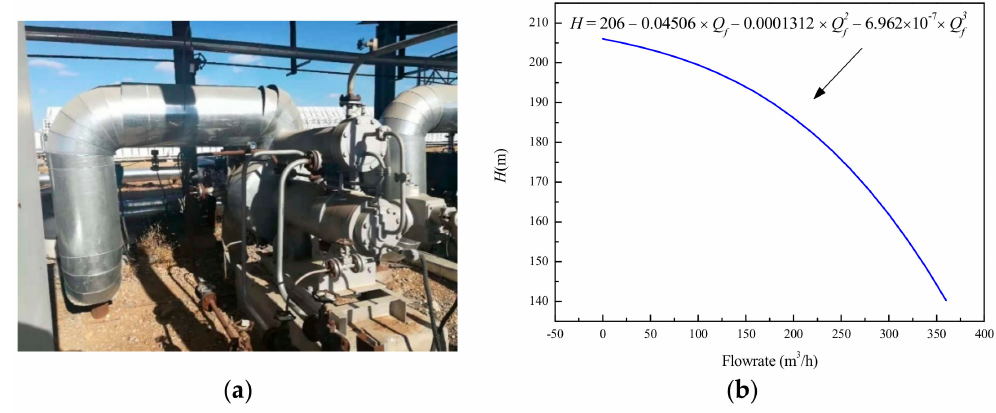
Figure 4. ( a ) View of pump; ( b ) pump’s performance